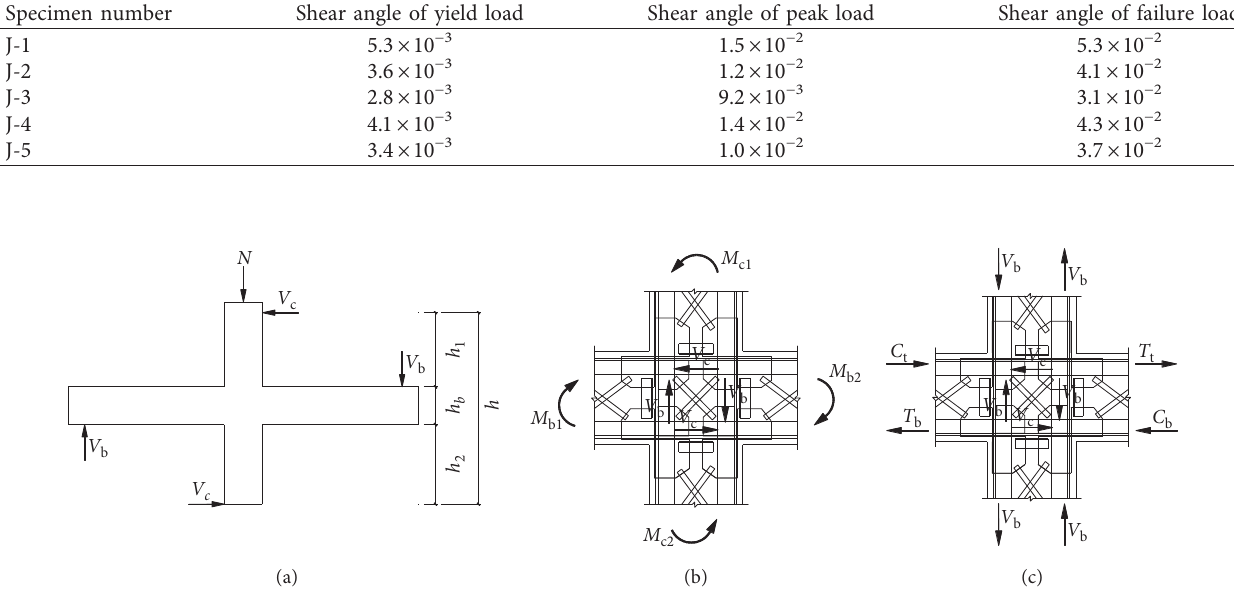
Figure 20: Nodal force relation. Table 9: Horizontal shear forces in the core area. Specimen number Horizontal shear forces in the core area: kN